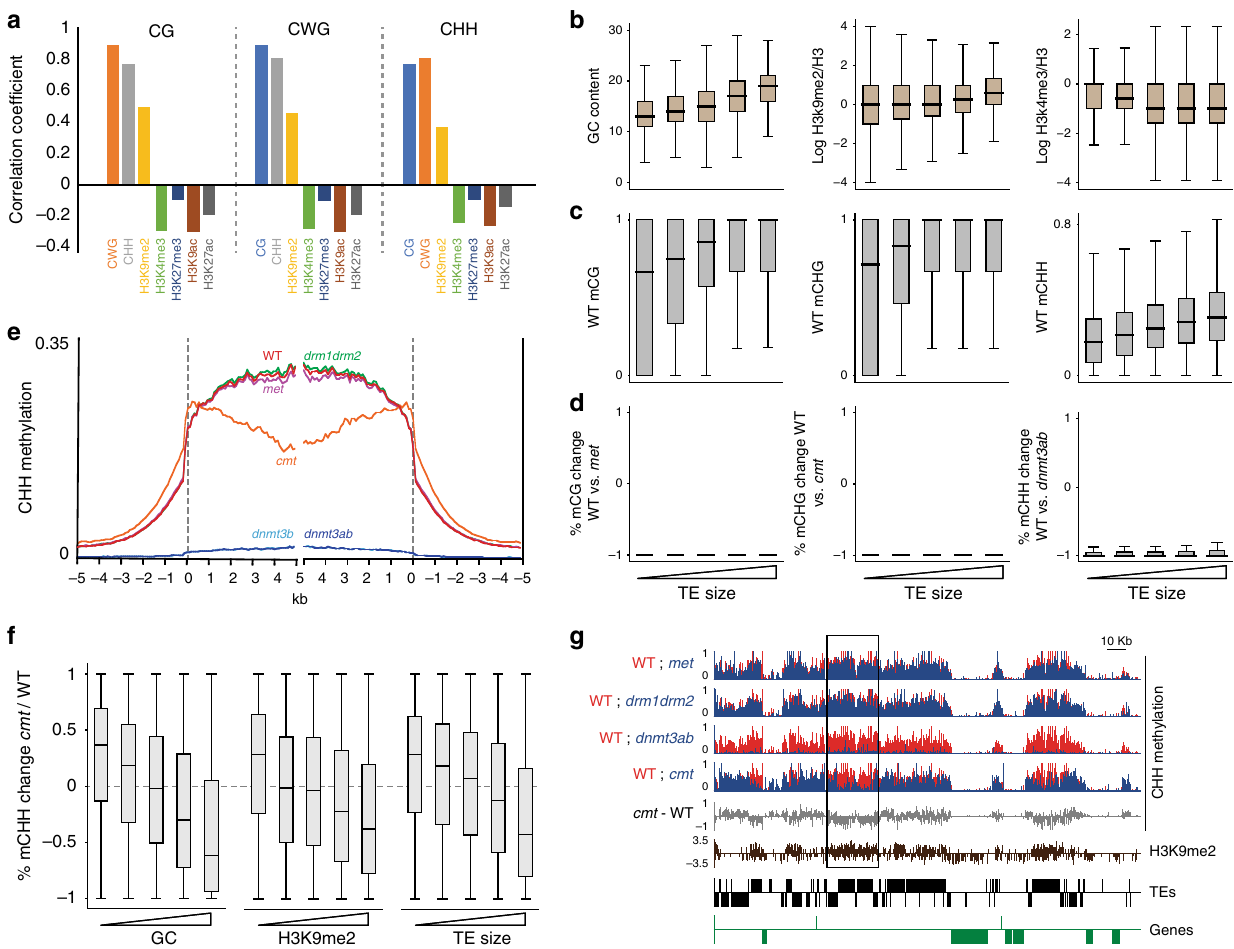
Fig. 3 PpCMT and PpDNMT3 methylate heterochromatin. a Pearson correlation coef fi cients between CG/CHG/CHH methylation, GC content, and indicated histone modi fi cations of TEs in 50 bp windows. b Box plots showing GC content, H3K9me2, and H3K4me3 levels in 50 bp windows within fi ve quantile TE sizes. c Box plots of averaged DNA methylation in 50 bp windows of WT protonoma over fi ve quantiles of TE sizes. d Box plots of percent- methylation-change between WT and indicated mutants 50 bp windows with a minimum 10% methylation in either of the samples, over TE size. e Patterns of TE CHH methylation in WT and indicated mutants as described in Fig. 2a. f Box plots showing the distribution of percent-methylation-change per 50 bp windows between WT and cmt mutant over H3K9me2, GC content, and TE size quantiles. g CHH methylation level (red WT, blue mutant), CHH methylation difference (cmt minus WT), H3K9me2, and gene/TE annotations of a representative region from Chromosome 1:459,000 – 702,000. Genes and TEs oriented 5 ′ to 3 ′ and 3 ′ to 5 ′ are shown above and below the line, respectively. Open black box marks a cmt hypo-methylated region